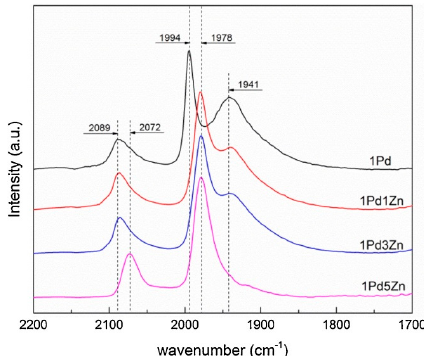
Figure 11. In situ DRIFTS of CO adsorption over different catalysts. Reprinted from Appl. Catal. A: General, 531, S. Wang, K. Gao, W. Li, J. Zhang, Effect of Zn addition on the direct synthesis of hydrogen peroxide over supported palladium catalysts, 89–95, Copyright (2017), with permission from Elsevier. Bands at 2089 (linear CO adsorbed on isolated surface Pd sites [51]), 1994 (bridged CO species on Pd edges [93]), and 1941 cm − 1 (bridged CO species on Pd atoms exposed at the surface of either (100) or (111) facets [39]) due to CO on different Pd sites were observed on the monometallic 1Pd catalyst [88]. Upon Zn addition, a red-shift of these peaks along with a gradual decrease in intensity of the peak at 1941 cm − 1 , related to bridged carbonyls on Pd atoms on either (100) or (111) facets, was observed (red and blue curves), which almost completely disappeared in the case of the